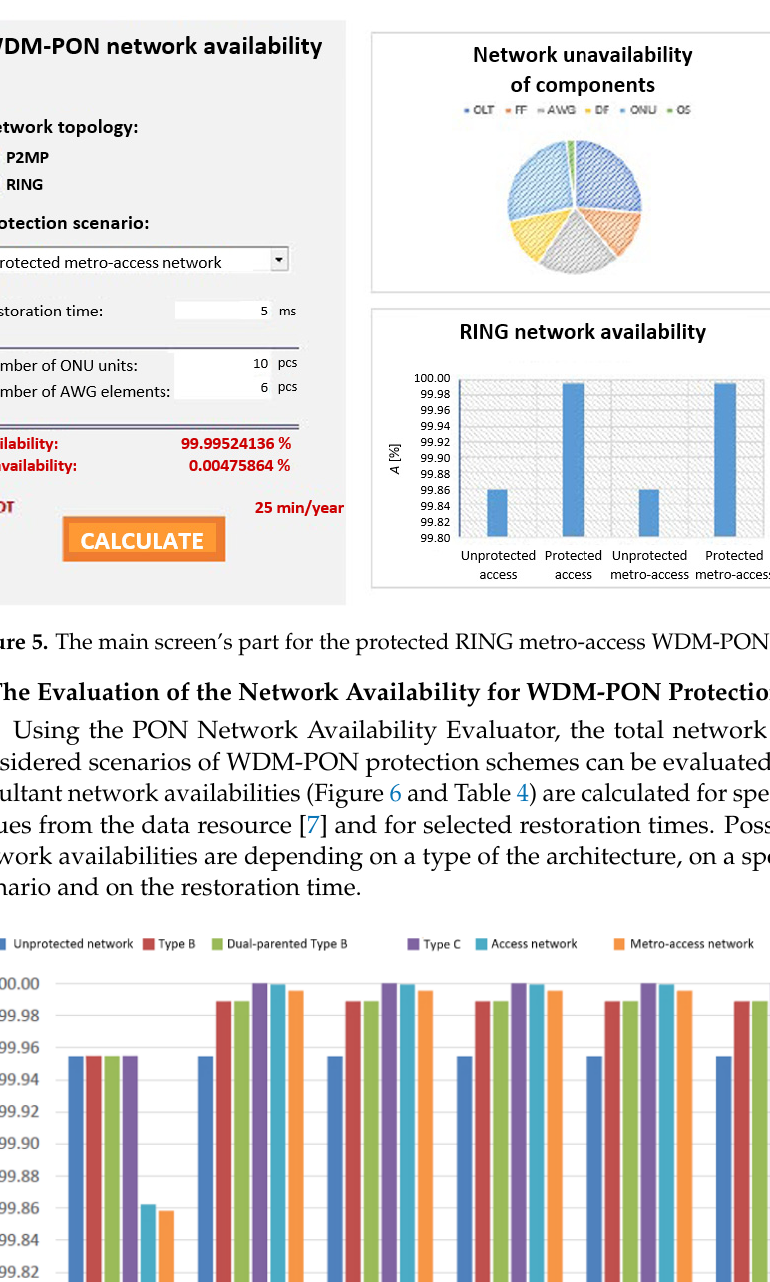
Table 4. The total WDM-PON network availability for selected restoration times.